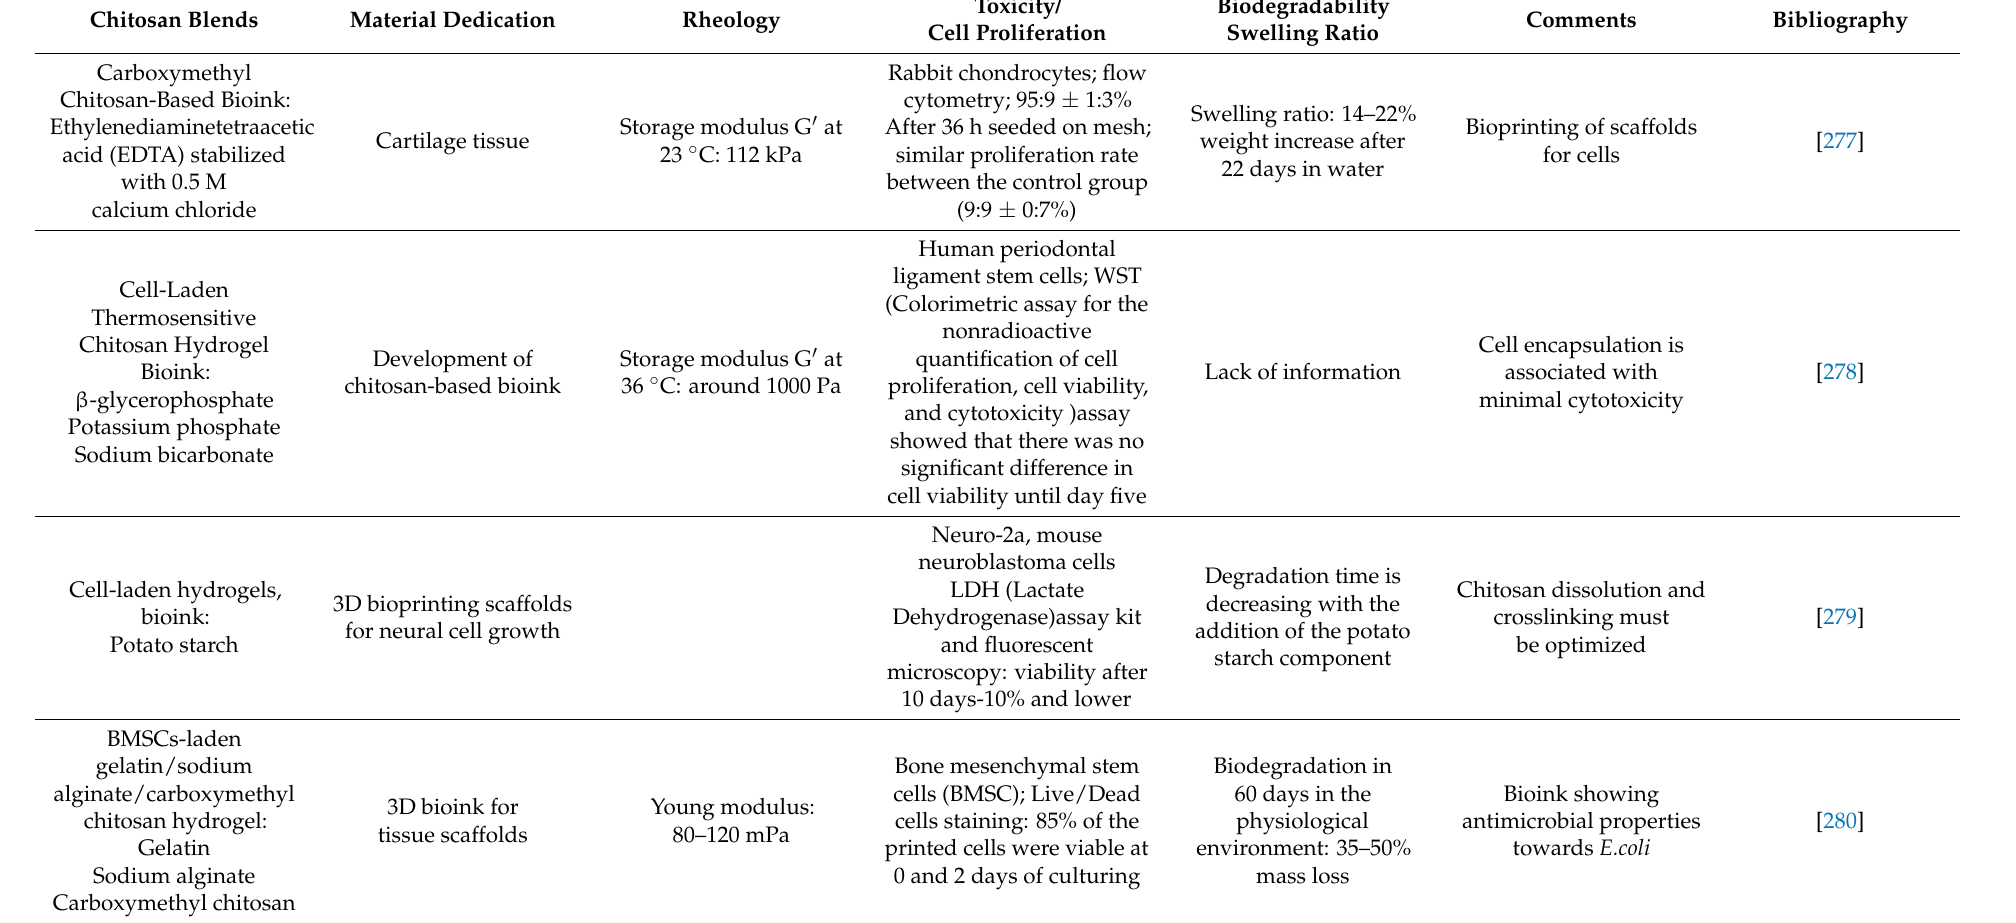
Table 2. Novel bio-inks for 3D printings based on